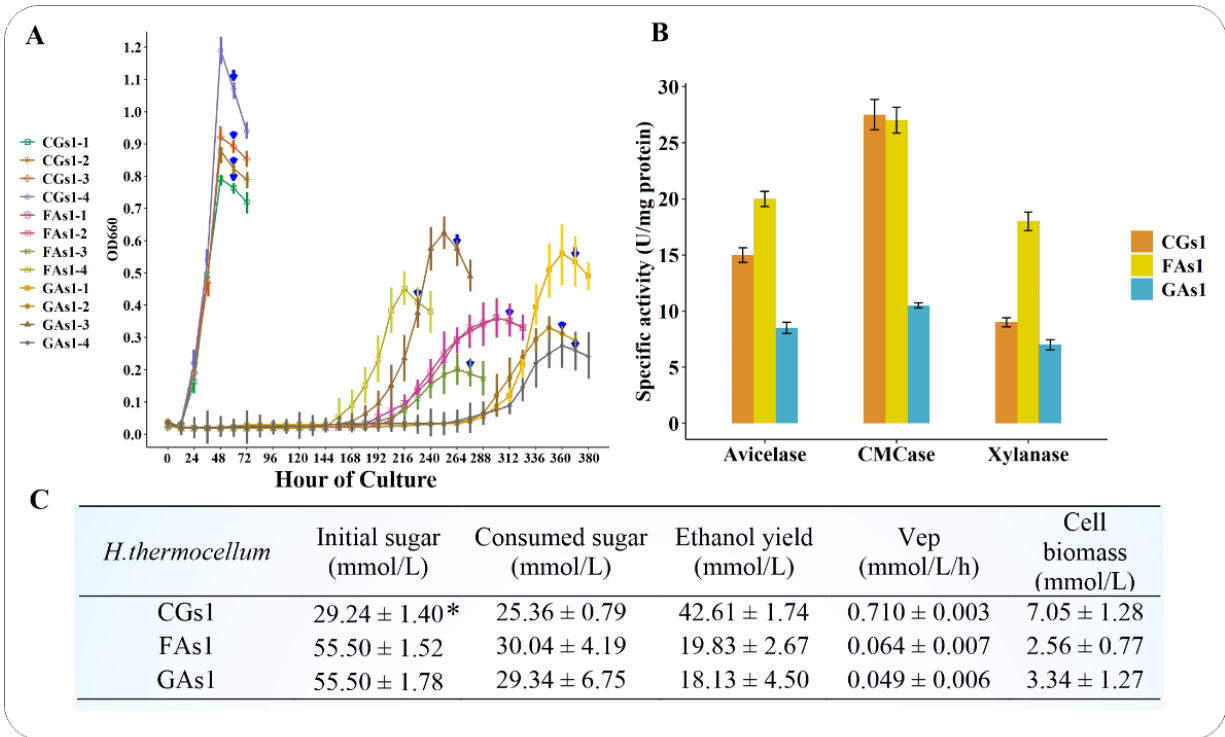
Figure 2. H. thermocellum growth patterns, cellulosomal enzyme activity, sugar consumption, and ethanol fermentation. ( A ) Growth profiles of CGs1, FAs1, and GAs1 in four biological replicates. The blue arrowheads indicate the sampling points used for RNA-seq, RT-qPCR, and cellulosome isolation. ( B ) Specific enzyme activity of the H. thermocellum cellulosome. ( C ) Sugar consumption, ethanol yield, volumetric ethanol productivity, and cell biomass of CGs1, FAs1, and GAs1. All data in Figure 2B,C represent the mean ± sd of biological triplicate. Note: * mmol glucose equivalents; Vep: Volumetric ethanol productivity (mmol/L/h).